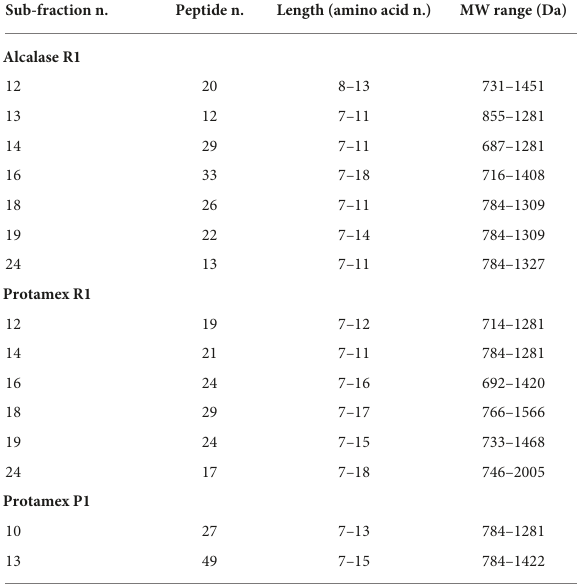
TABLE 3 Characteristics of the peptide pool present in sub-fractions obtained from Alcalase and Protamex R1, and Protamex P1 fractions and showing the highest anti-tyrosinase activity. Sub-fractionn.